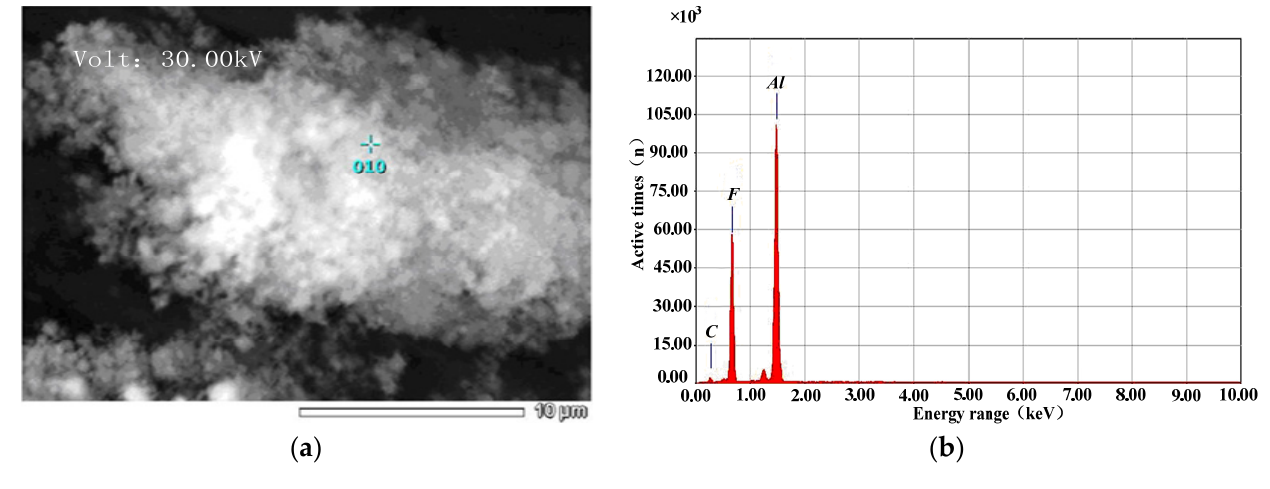
Figure 7. Inspection GIS solid samples with a scanning electron microscope and energy spectrum.